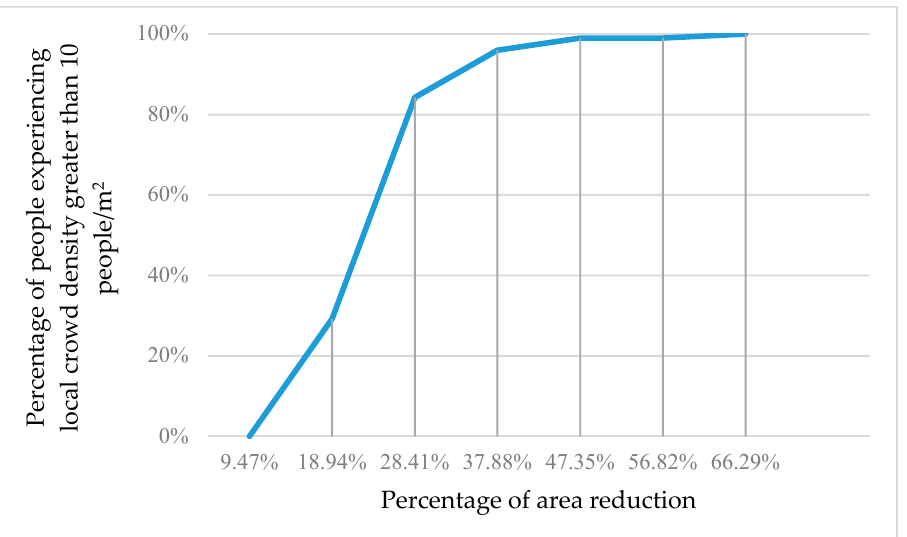
Figure 13. The percentage of people experiencing local crowd density greater than 10 people/m 2 as the occupied area shrinks.